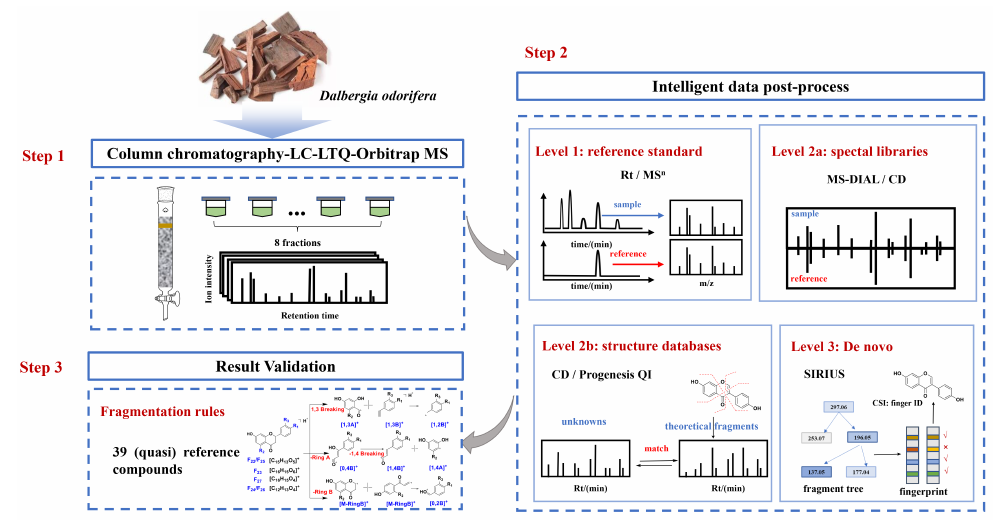
Figure 1. A flowchart for software-assisted multi-tiered mass spectrometry identification of flavonoids in Dalbergia odorifera